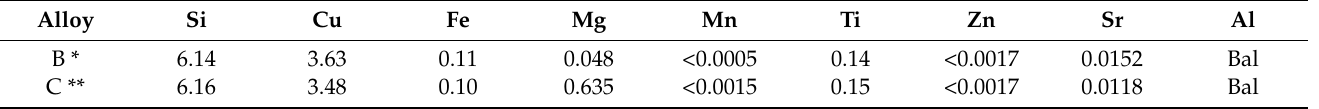
Table 1. Chemical compositions (wt.%) of the two main alloys used in the present work.